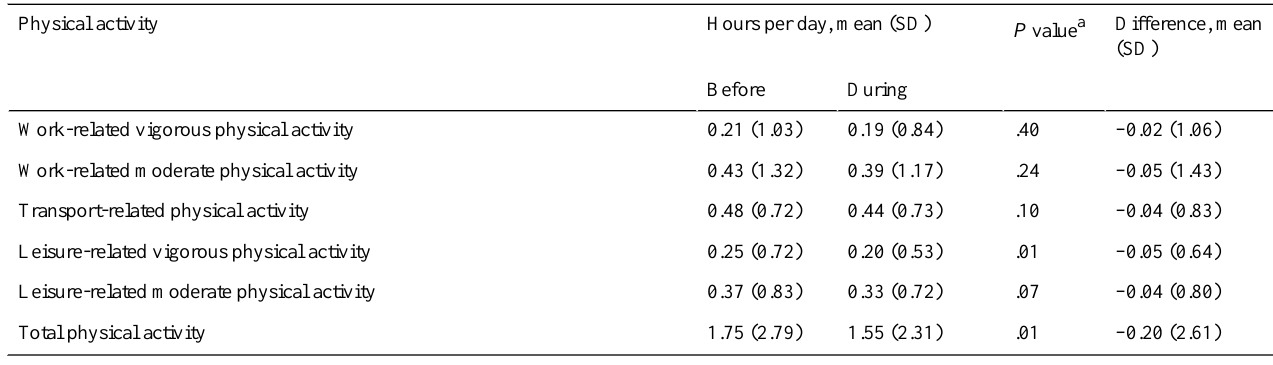
Table 3. Workers’domain-specific physical activity before (February 2019) and during (July 2020) the COVID-19 outbreak in Japan (n=1315).